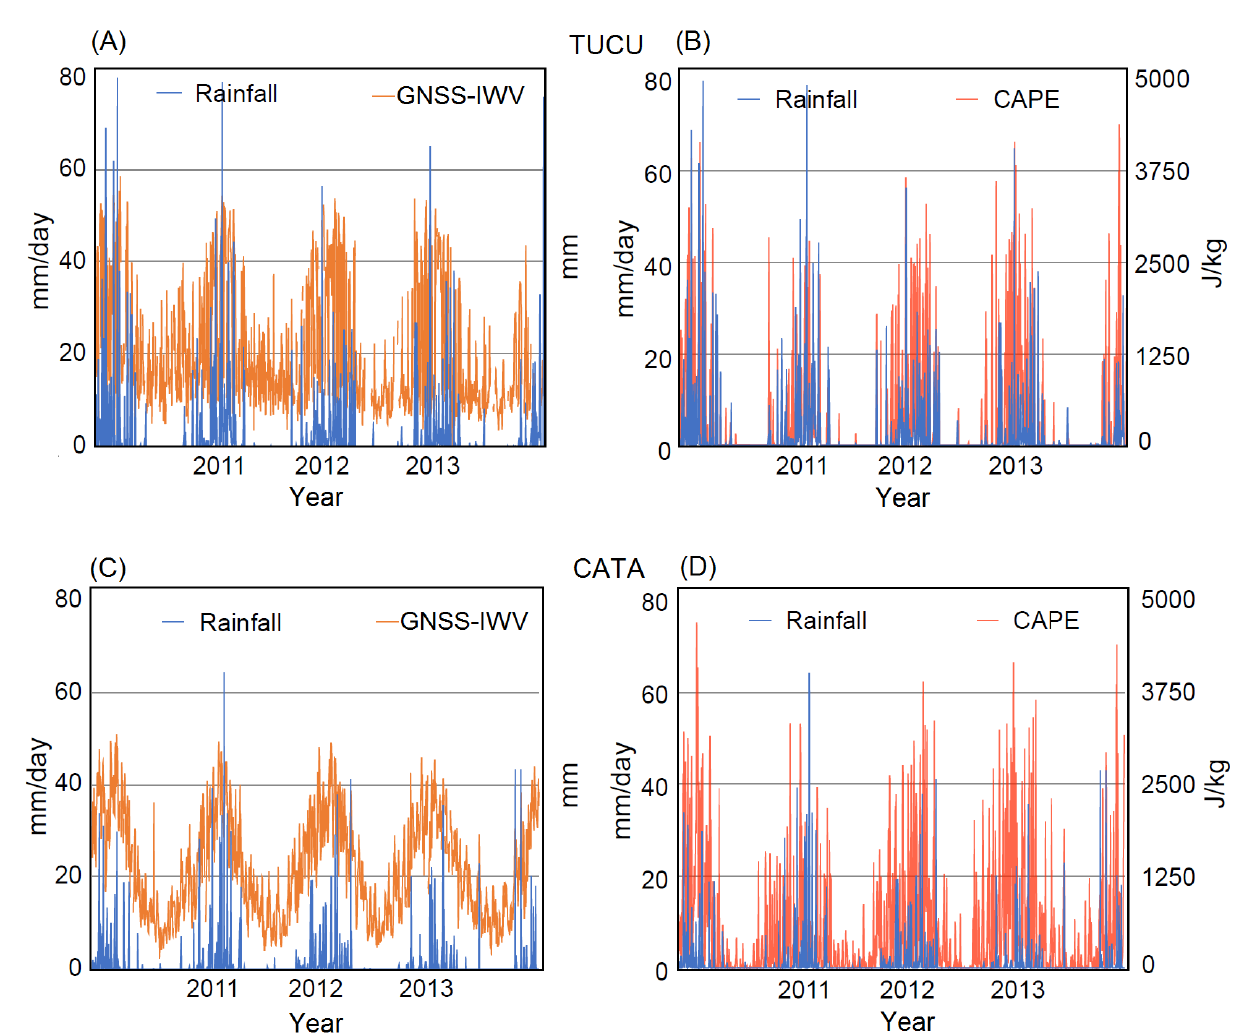
Figure 4. The daily mean GNSS-integrated water vapour (orange line) vs. daily mean rainfall from TRMM data (blue line) ( A ) for TUCU and ( C ) for CATA stations and daily mean CAPE (red line) from ERA-interim vs. daily mean rainfall from TRMM data (blue line) ( B ) for TUCU and ( D ) for CATA stations for (2010–2013). Both datasets represent a high seasonal agreement with rainfall in both